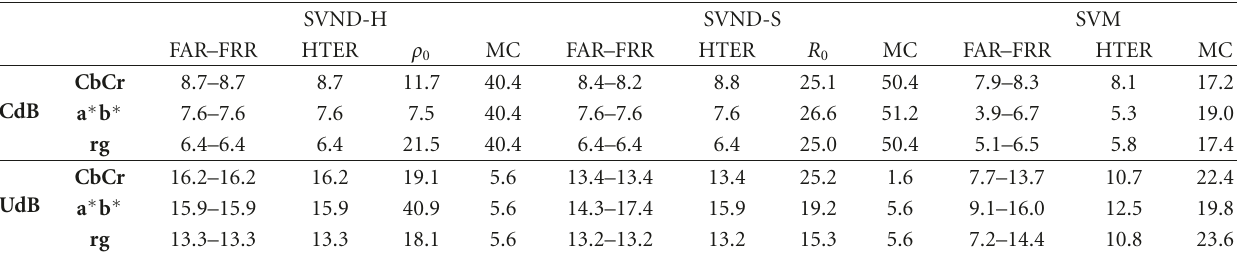
Table 4: Values of HTER (%) and complexity for SVND-H ( nu = 0 . 01, σ = 0 . 05 for CdB; nu = 0 . 08, σ = 0 . 2 for UdB), SVND-S ( C = 0 . 5, σ = 0 . 05 for CdB; C = 0 . 05, σ = 0 . 1 for UdB) and SVM ( C = 46 . 4, σ = 1 . 5 for CdB; C = 215 . 4, σ = 2 . 5 for UdB).